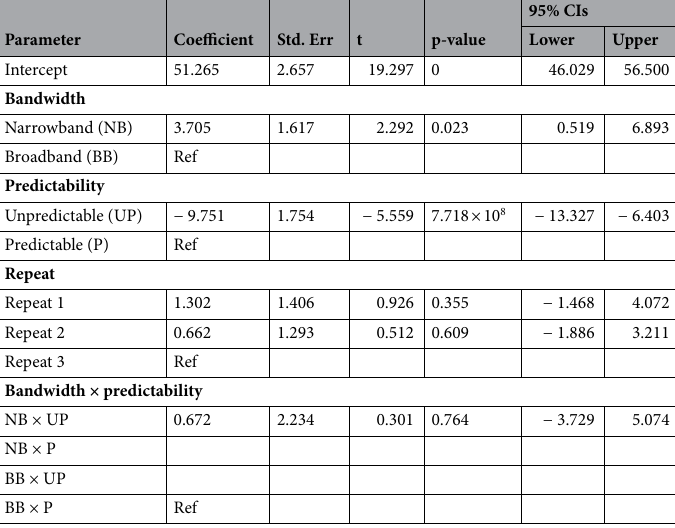
Table 1. Experiment 1: Fixed coefficients of the Generalized Linear Mixed Model (GLMM), including: estimate strength (Estimates), standard errors (Std. Errs), t-statistics (t), probability value (p-value) and 95% confidence intervals (Cis), for each fixed effect and the interaction bandwidth × predictability.